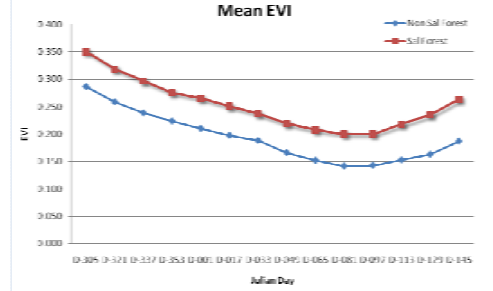
Figure 8: Mean EVI graph for Sal and Non Sal forest